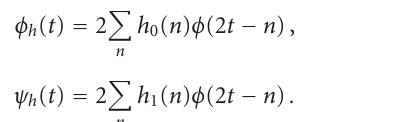
Figure 4: Impulse response of dual-tree complex wavelets at 4 levels and 6 directions. (a) Real part. (b)